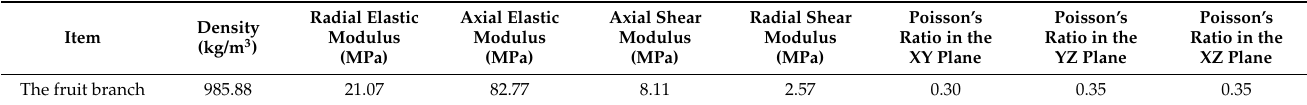
Table 3. The mechanical properties of the fruit branch.